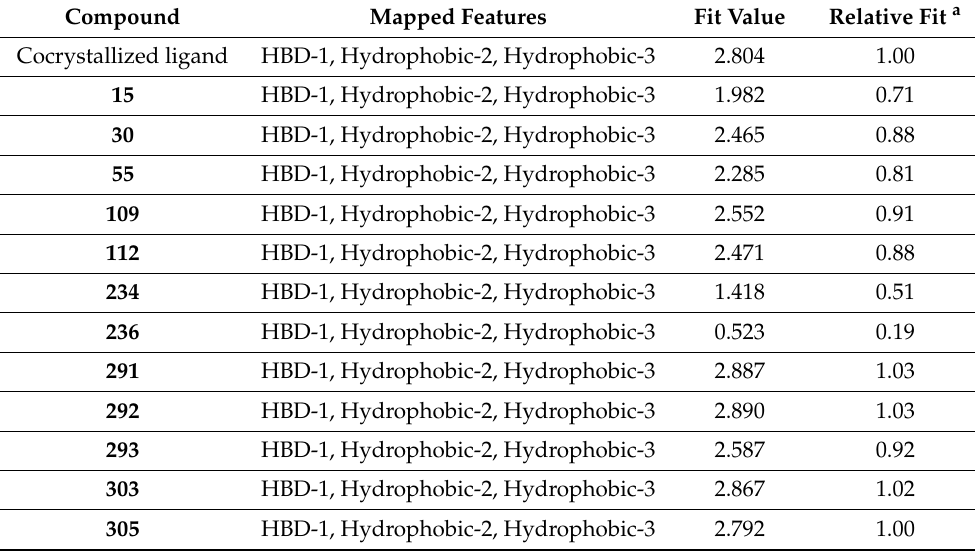
Table 2. Fit value and relative fit of the tested metabolites and GWS